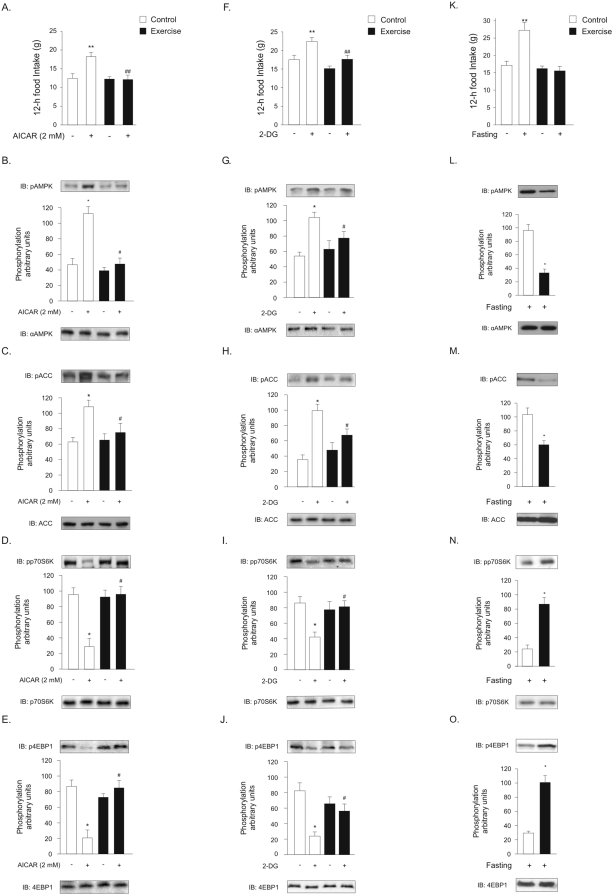
AICAR, 2-DG and fasting effects on 12-h cumulative food intake and AMPK/mTOR signaling, in the hypothalami of control and exercised rats.(a) AICAR (2 mM) was administered in control and exercised rats. Animals were immediately exposed to food for a 12-hour period (n = 12–15 animals per group). (b, c, d, e) Representative Western blots of five independent experiments showing hypothalamic lysates from Wistar rats. (f) 2-DG (500 mg/Kg) was administered in control and exercised rats. Animals were immediately exposed to food for a 12-hour period (n = 12–15 animals per group). (g, h, i, j) Representative Western blots of five independent experiments showing hypothalamic lysates from Wistar rats. (k) Exercise decreases food intake in the fasting state (48 h fasting). Animals were immediately exposed to food for a 12-hour period (n = 12–15 animals per group). (l, m, n, o) Representative Western blots of five independent experiments showing hypothalamic lysates from Wistar rats. Phospho-AMPKthr172, threonine-phosphorylated AMPK and total AMPK; phospho-ACCser79, serine phosphorylated ACC and total ACC; phospho-p70S6Kinasethr389, threonine phosphorylated p70S6Kinase and total p70S6K; phospho-4EBP1thr70, threonine phosphorylated 4EBP1 and total 4EBP1. Data are the means±SEM. * p<0.05, ** p<0.01, vs. control group; # p<0.05, ## p<0.001 vs. AICAR- or 2-DG-stimulated control group.